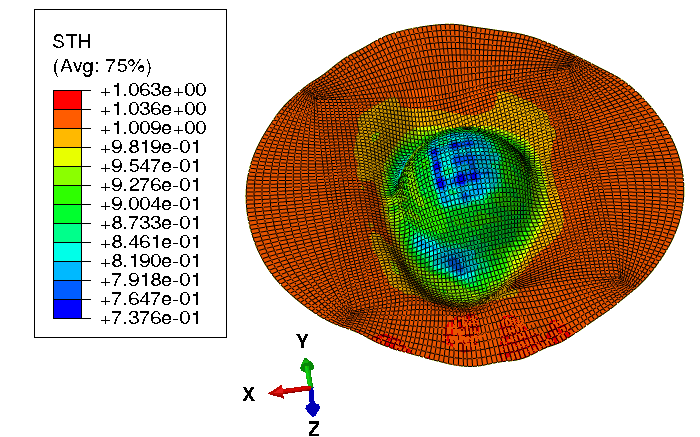
Figure 22. Distribution of shell thickness decreasing at ambient temperature: multistep